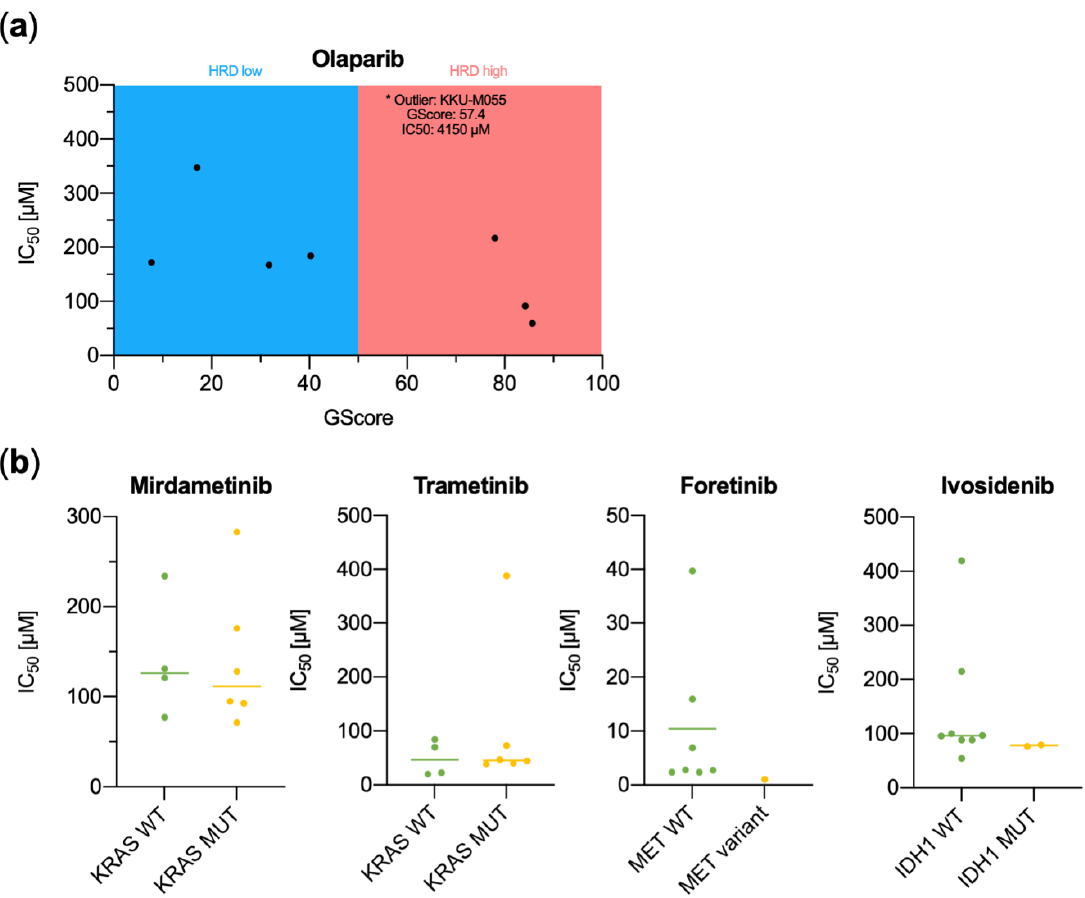
Figure 3. IC 50 values as determined by Xcelligence ® gradient concentration measurements for the compounds ( a ) Olaparib displayed against genomic scar score (GScore), ( b ) Mirdametinib and Trametinib with regard to KRAS mutational status, Foretinib with regard to detected MET splice site variants and gene fusions, and Ivosidenib sorted by IDH1 mutational status. HRD, homologous DNA repair deficiency; WT, wild type; MUT, mutated. Table 4. IC 50 -values [M] of 10 evaluable CCA cell lines. ND, not determined. RBE